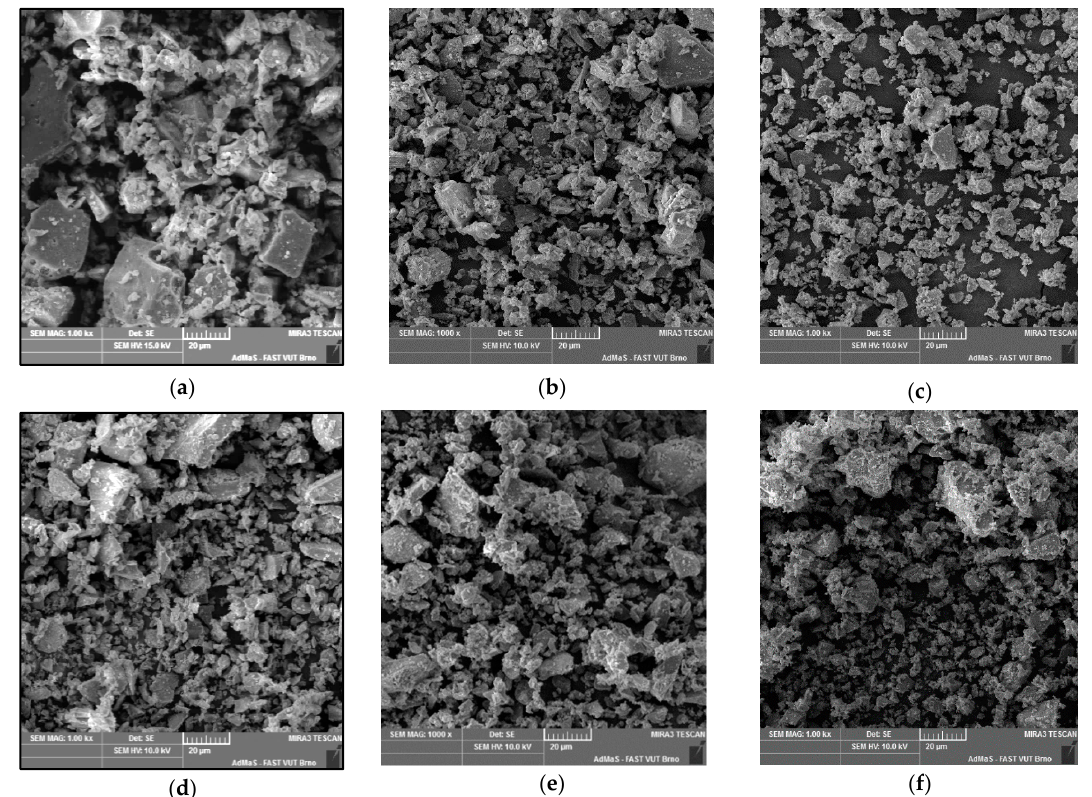
Figure 2. Comparison of the original and post ‐ milling shapes of cement particles for: 200 m 2 /kg sample, ( a ) original particles; ( d ) milled particles; 300 m 2 /kg sample, ( b ) original particles; ( e ) milled particles; 450 m 2 /kg sample, ( c ) original particles; ( f ) milled particles.